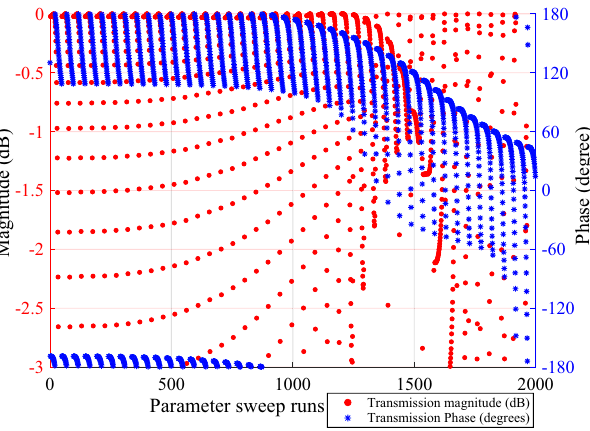
Figure 4. Transmission phases and corresponding transmission magnitudes (greater than − 3 dB) as a function of the parameter sweep on radius and side-length of metallic patches.